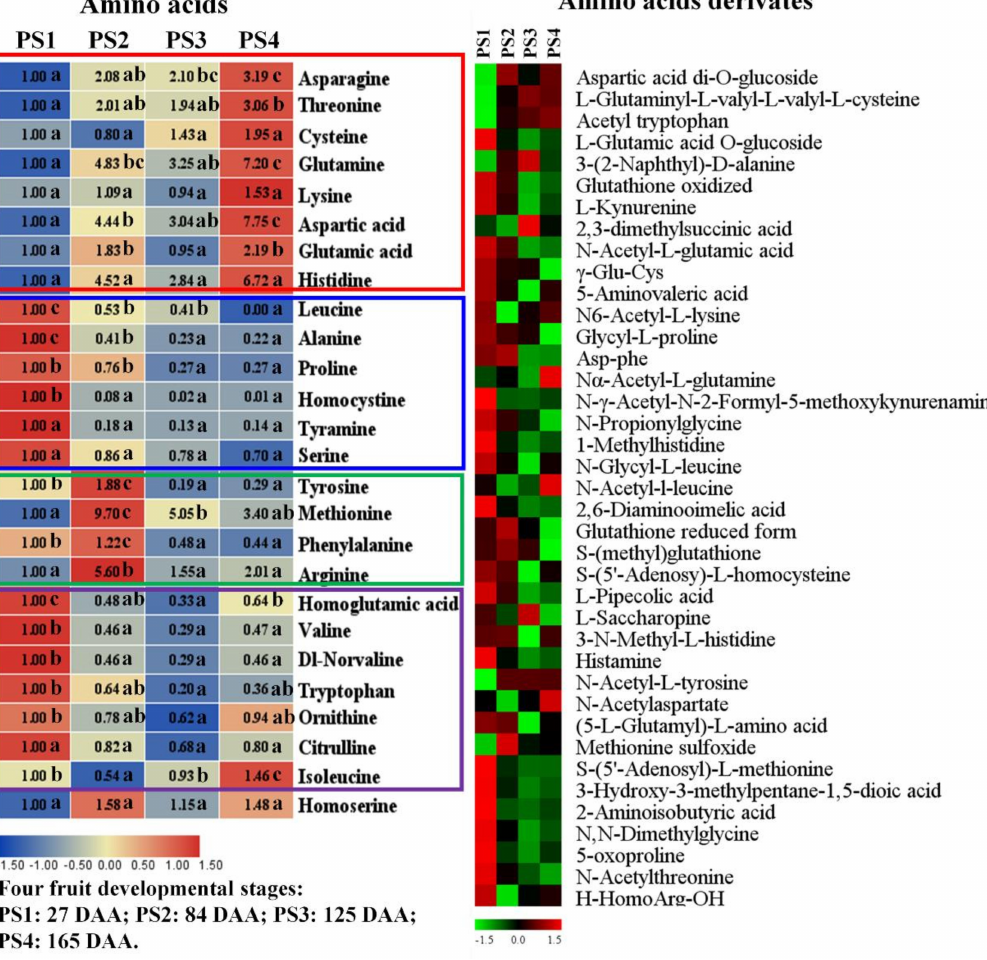
Figure 4. Amino acids (left) and their derivates (right) detected by widely-targeted UPLC-MC during four fruit developmental stages. For the amino acids, the fold changes of each metabolite among four stages were displayed in heat map which used the first stage of 27 Days After Anthesis (DAA) as the calibrator. PS1, 2, 3, and 4 represents four fruit developmental stages: 27, 84, 125, 165 Days After Anthesis (DAA), respectively. Significant analysis was performed by SPSS software based on Tukey’s test at p < 0.05 level and showed with lower cases a, b, and c in figure. Di ff erent letters indicate significant di ff erences between two samples. For the amino acids derivates, the colors indicate the proportional content of each identified amino acids derivates as determined by the average peak response area with R scale normalization. PS1, 2, 3, and 4 represents four fruit developmental stages: 27, 84, 125, 165 Days After Anthesis (DAA), respectively. Three independent replicates were performed for each